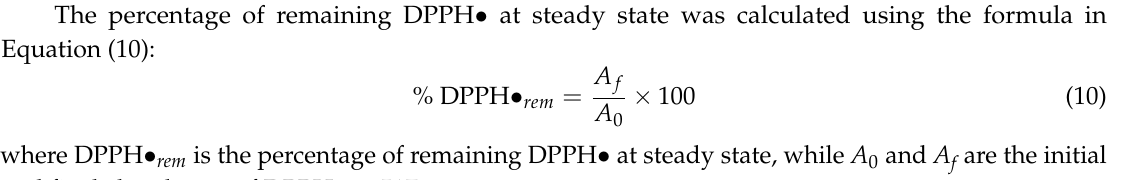
Figure 4. Calibration curve of DPPH solution.